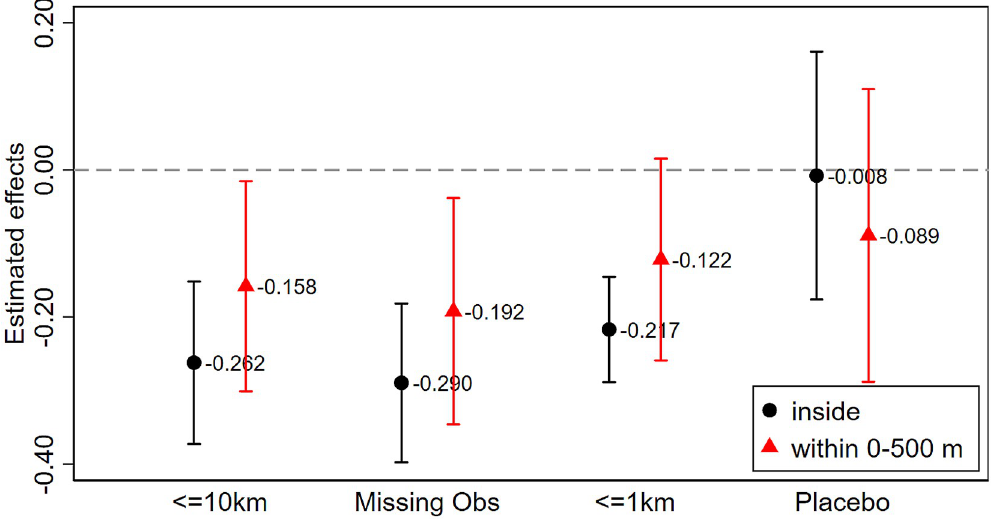
Fig 5. Facemask regulations and footfall. Dependent variable is the log footfall. Inside denotes regulated shopping streets and within 0–500m denotes unregulated shopping streets within 500m from regulated shopping streets. All regressions include RMC and date fixed effects. Tails denote 95% confidence intervals constructed from two-way clustered standard at postcode and date levels.